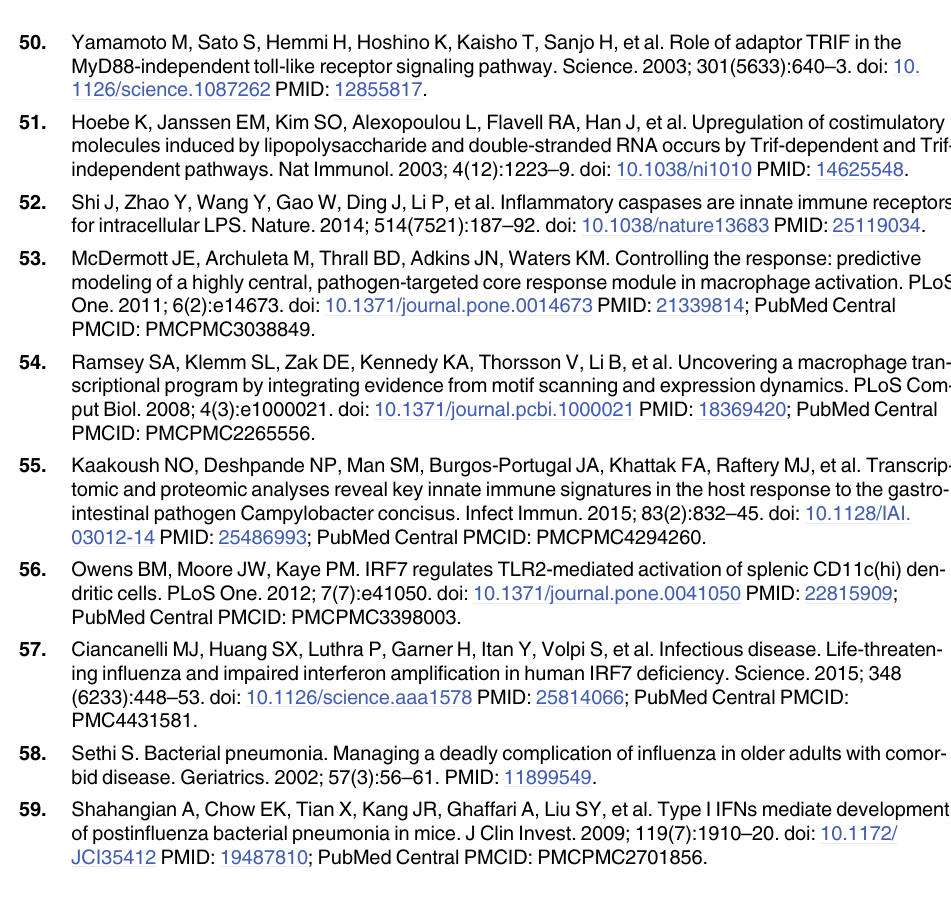
PLOS ONE | DOI:10.1371/journal.pone.0159329 July 19, 2016 22 /